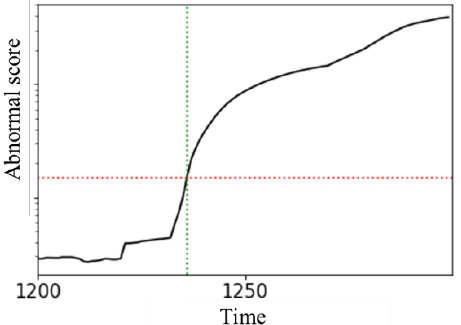
Figure 21. Fault detection when t = 1236 min in Mode 3.